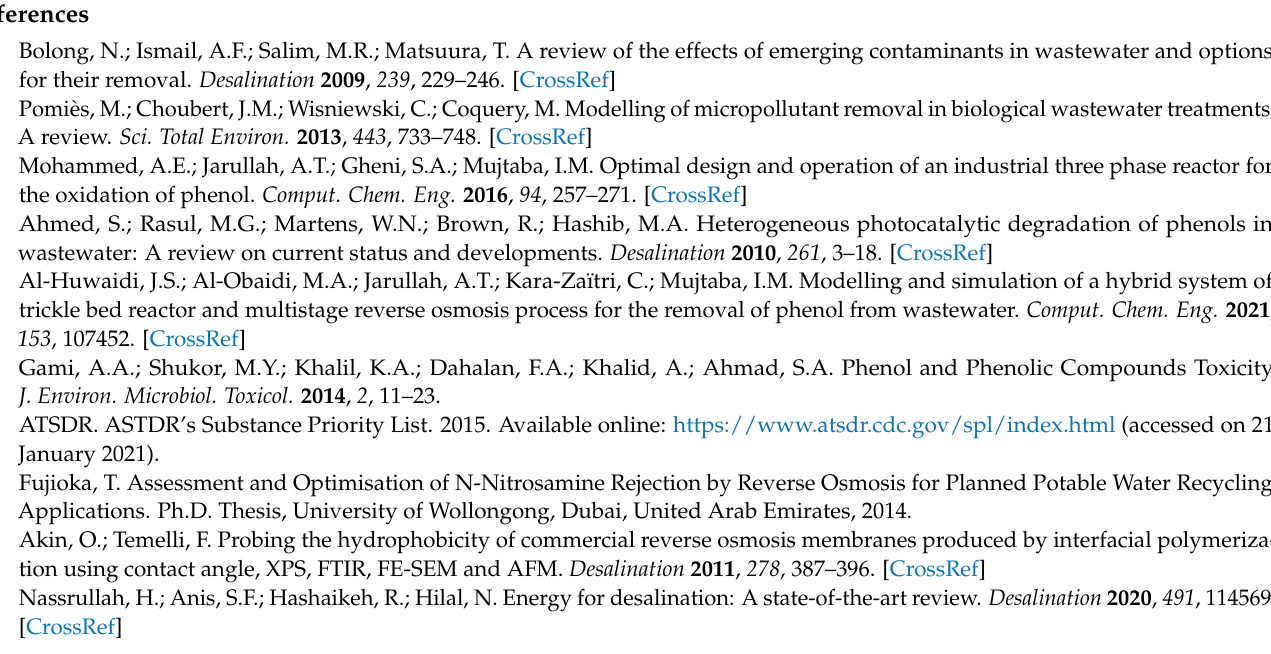
Figure A1. The pseudocodes of the SCGA (adapted from Al-Obaidi et al.